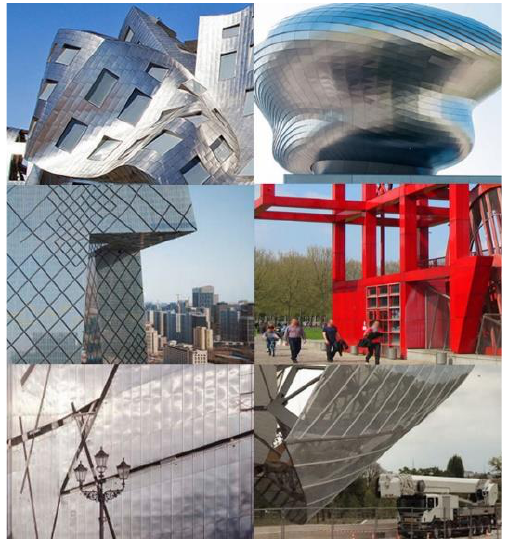
Figure 1. These are vignettes of architectural loci showing ‘irrational bits’. They have been brought to realization by architects with practices that support aspiration through measuring it as technicist contradiction of architectural value. They serve what cannot be objective measure and what had no form in dwelling by giving it measure. Their architecture accepts that contradiction, isolating aspiration from technicist measurement/discovery in specific intentional modes of practice, to carefully protect the architectural